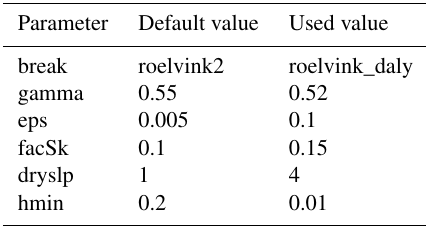
Table 2. Non-default XBeach parameterizations used in erosion